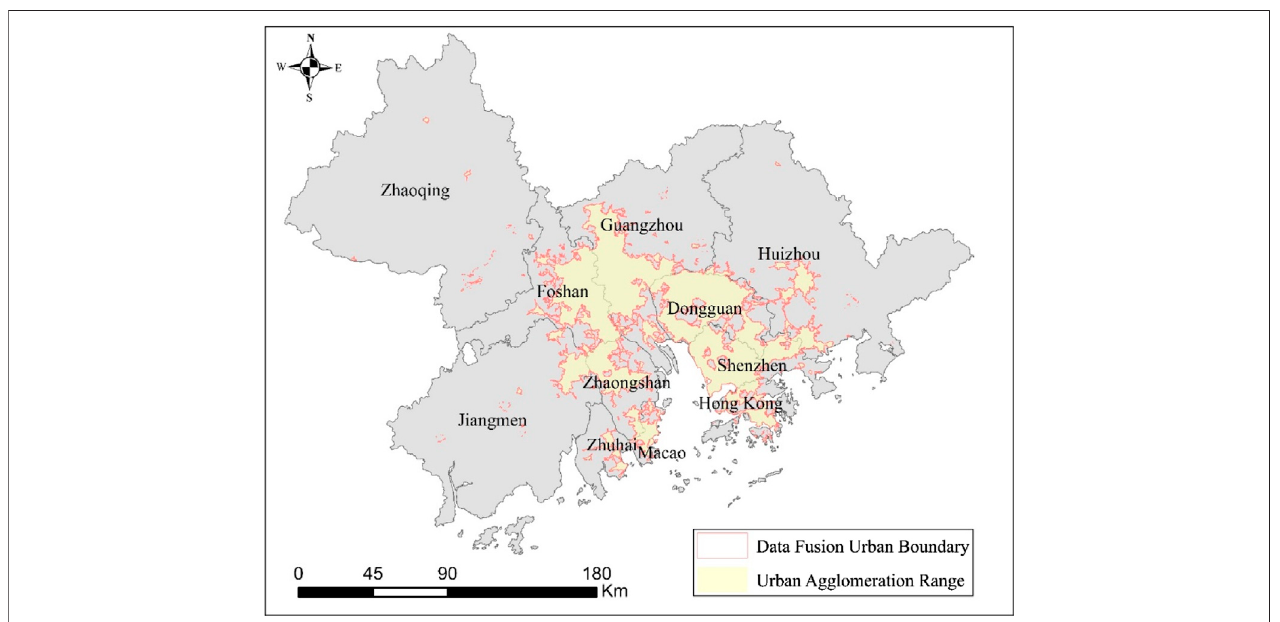
FIGURE 7 | Urban agglomeration boundary delineated using data fusion.